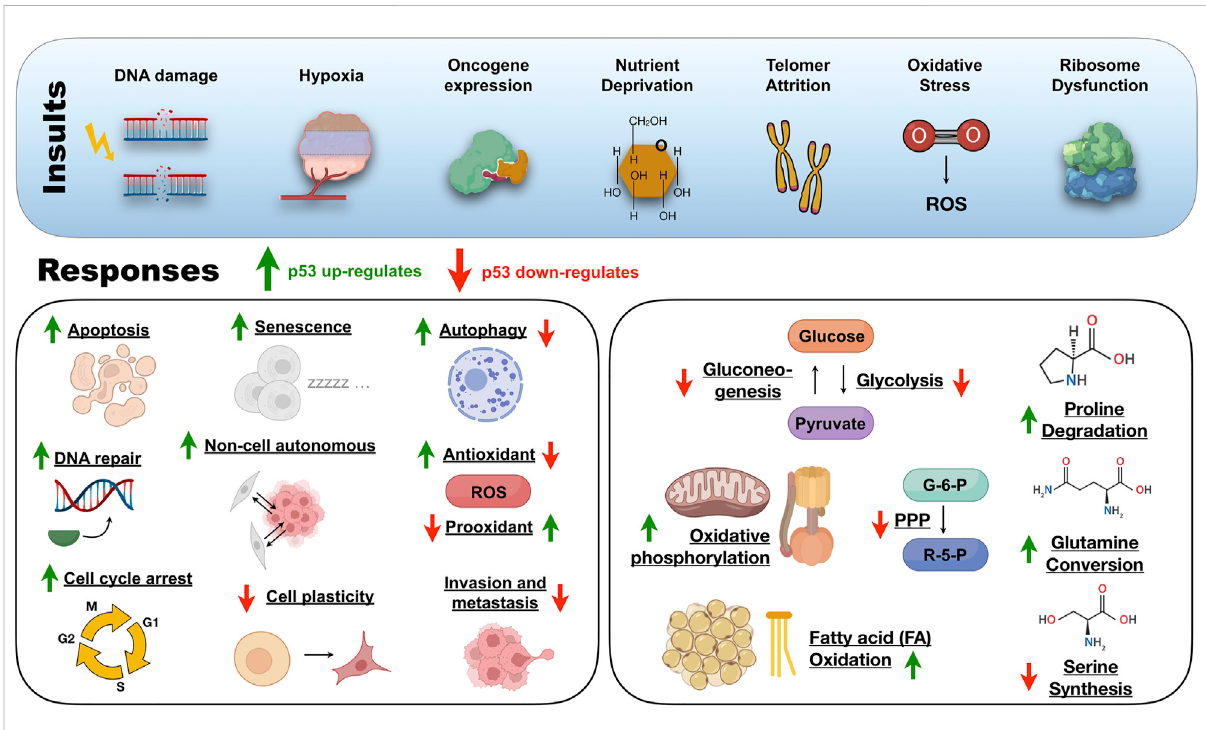
FIGURE 3 An overview oftheinsultsand responses triggered bytheprotein ofathousand faces under physiologicalcircumstances. ROS,reactiveoxygen species; PPP, pentose phosphate pathway; G-6-P, glucose-6-phosphate; R-5-P,